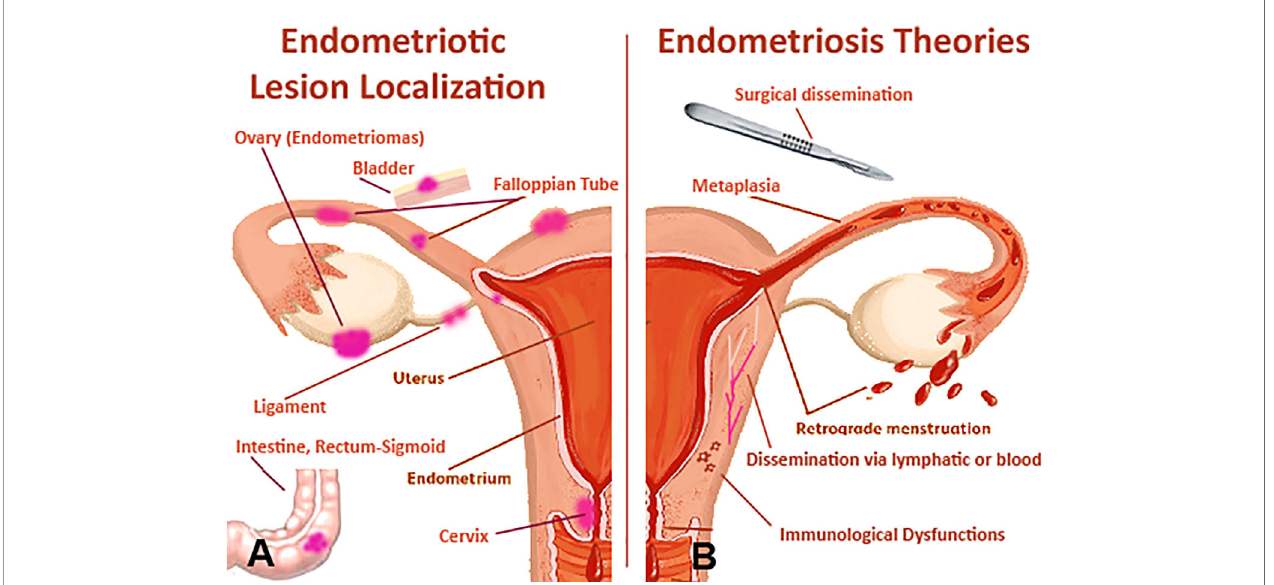
FIGURE 1 | Pathophysiological features of endometriosis (EM). (A) the female anatomy with areas that are commonly affected by EM. (B) likely pathogenic mechanisms involved in EM: potential origins of the endometriotic lesions include surgical dissemination, transplantation of endometrial tissue through retrograde menstruation, and in situ coelomic metaplasia of the peritoneal lining. Vascular or lymphatic metastasis occurs rarely, in cases of extrapelvic lesions. Super fi cial and deep endometriotic lesions are established and maintained through interacting molecular mechanisms that promote cellular adhesion and proliferation, systemic and localized steroidogenesis, localized in fl ammatory response and immune